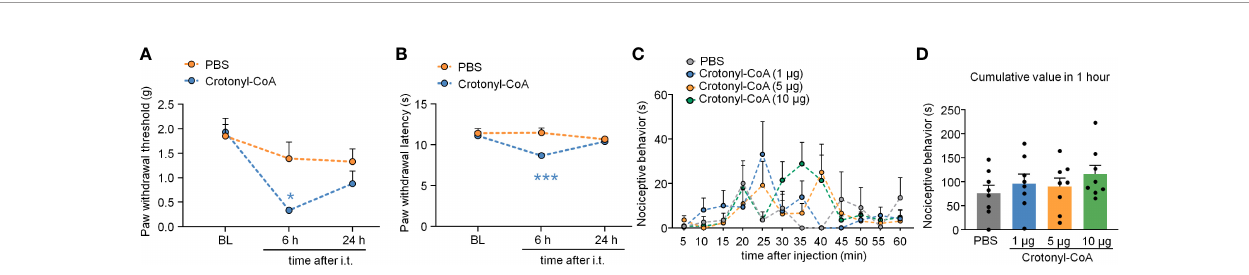
FIGURE 8 | Intrathecal administration of Crotonyl-CoA induced pain sensitivity. (A, B) Intrathecal injection of Crotonyl-CoA markedly induced plantar mechanical pain and thermal hyperalgesia in mice. * P <0.05, *** P <0.001, compared with the PBS group, n=6-7 mice per group, Two-way RM ANOVA followed by Bonferroni ’ s test. (C, D) Mice that received an intraplantar injection of different doses of Crotonyl-CoA did not exhibit nociceptive behavior. N=8 mice per group, Two-way RM ANOVA (C) or one-way ANOVA (D) followed by Bonferroni ’ s